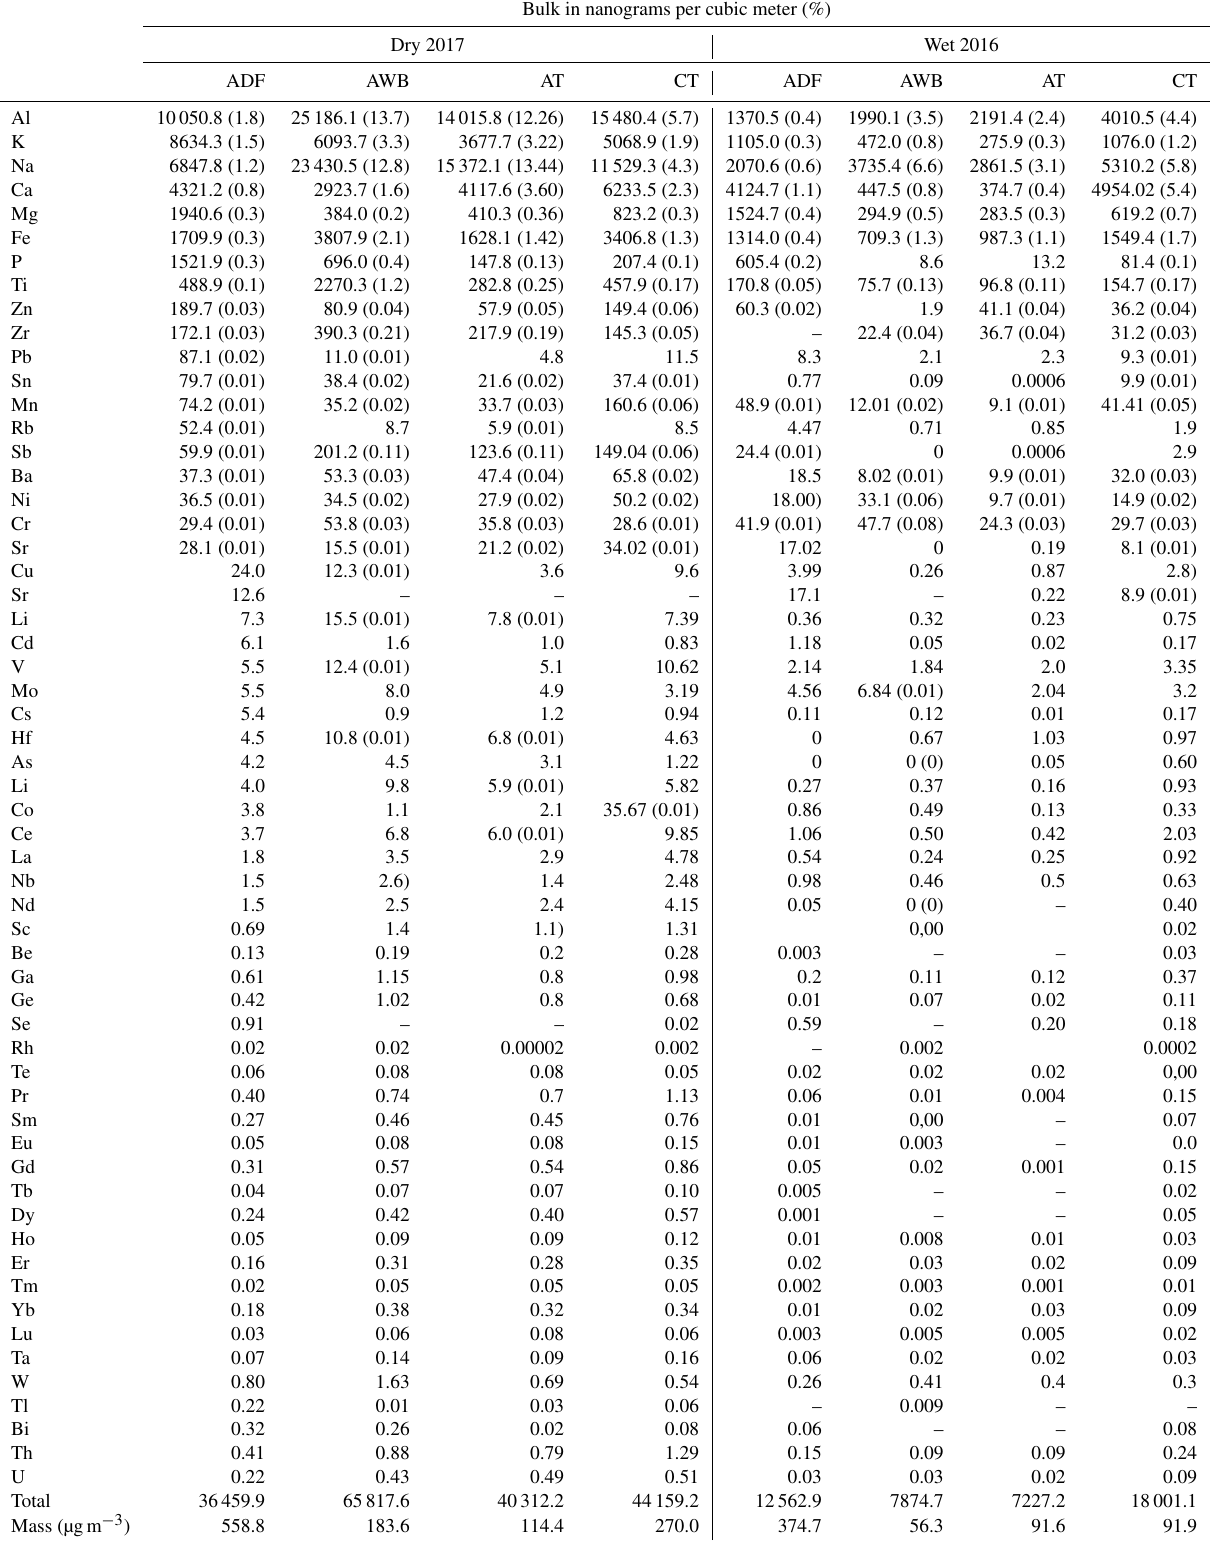
Table 3. Trace element concentrations for bulk aerosol for each site and for DS2017 and